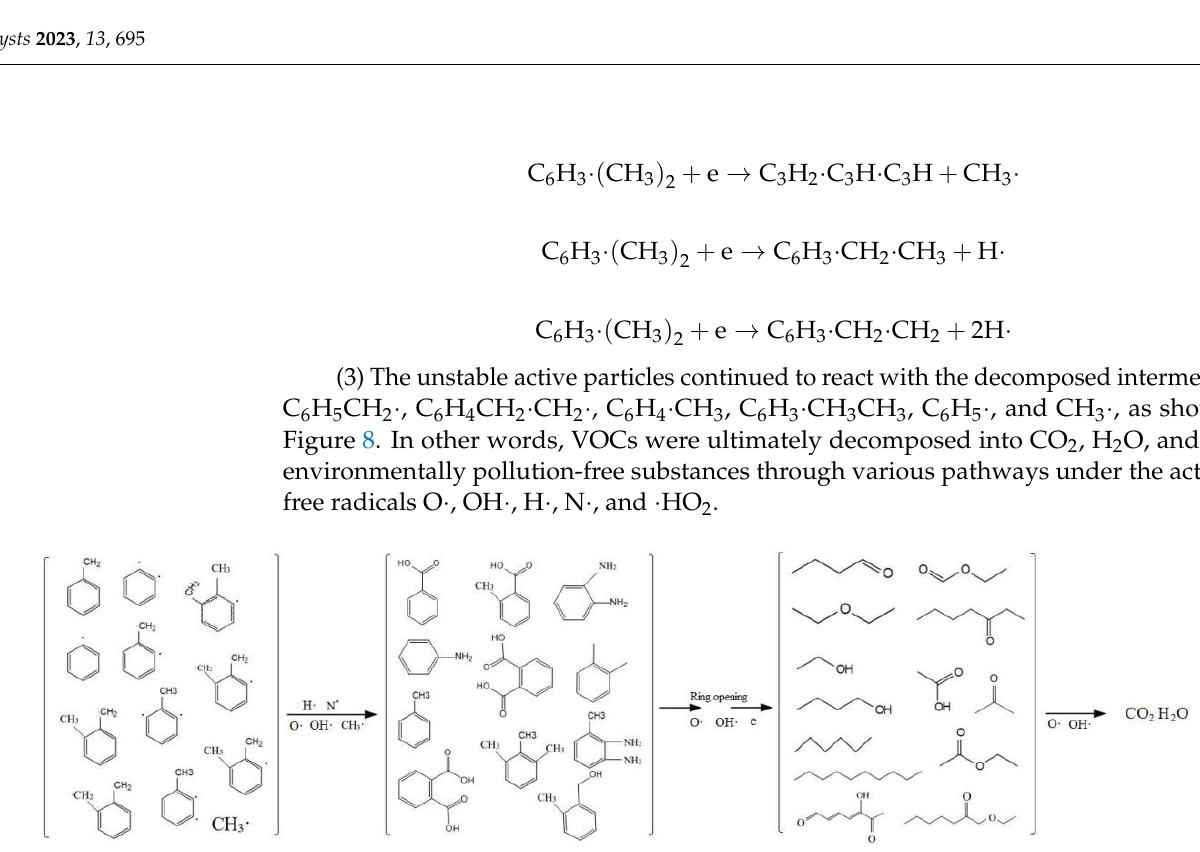
Figure 8. Schematic diagram of reaction between decomposed intermediates and active particles. Table 2. The reaction of breaking different chemical bonds in toluene and o-xylene [56]. Chemical Bonds Energy/eV Bond Breaking Reactions That Occurred after